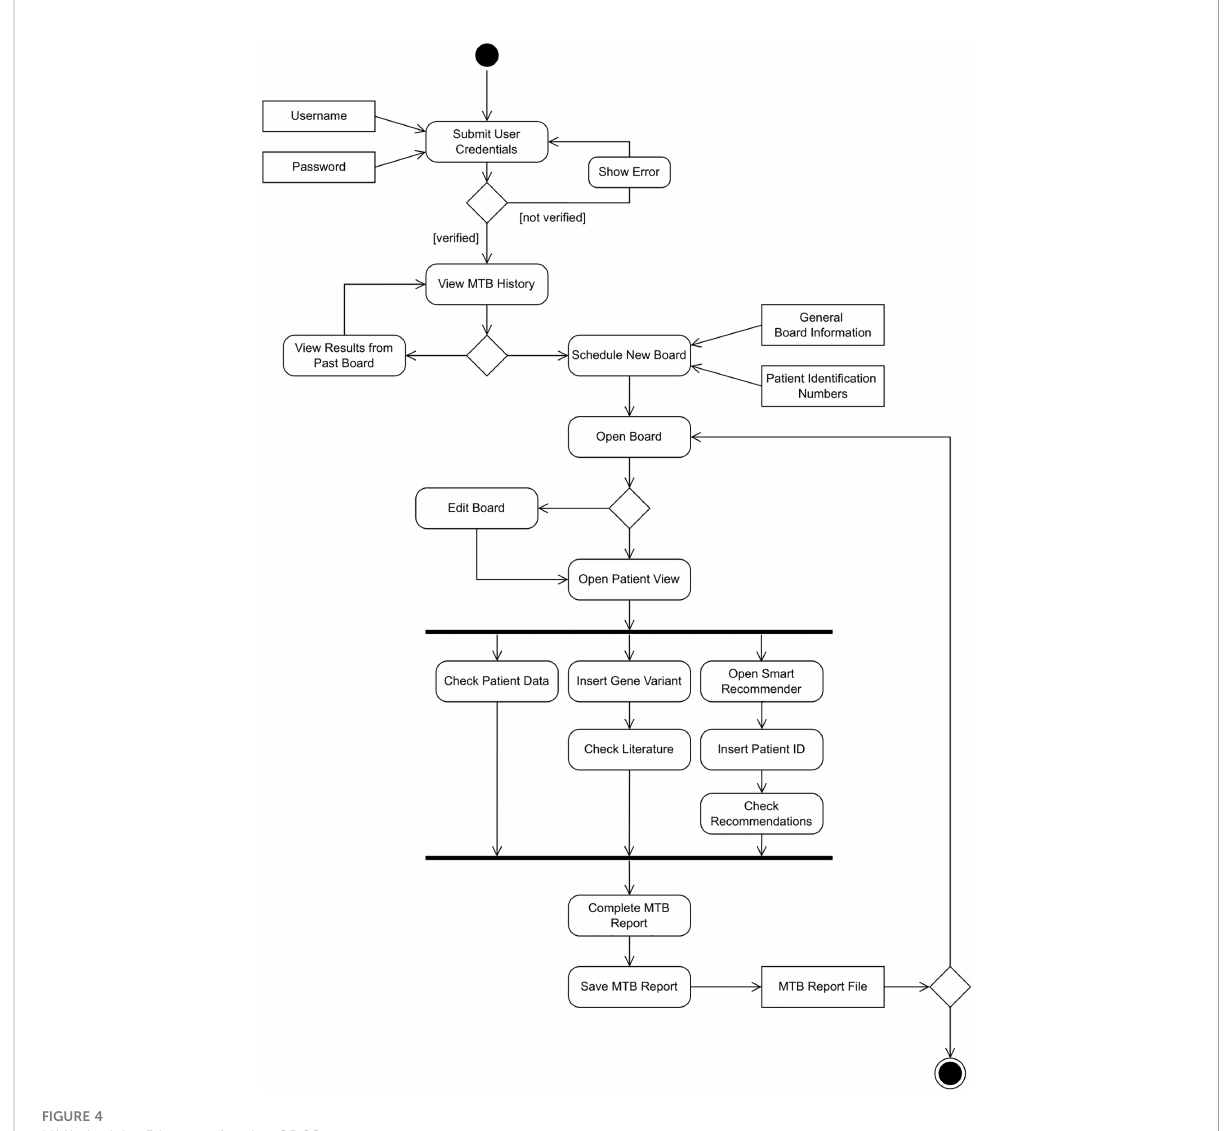
FIGURE 4 UML Activity Diagram for the